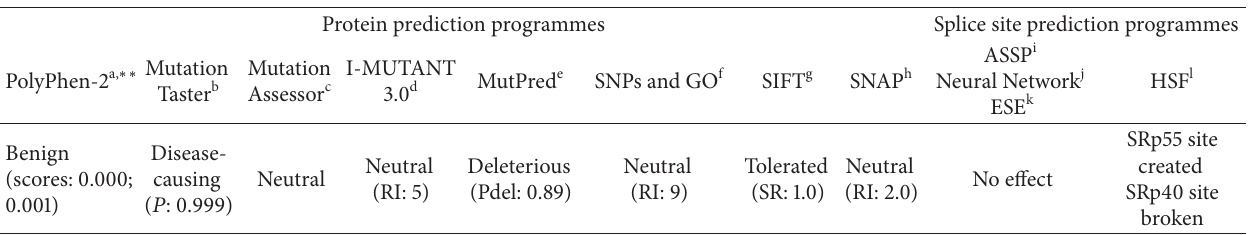
Table 1: In silico analysis of GPD1L gene ∗ mutation. Protein prediction programmes Splice site prediction